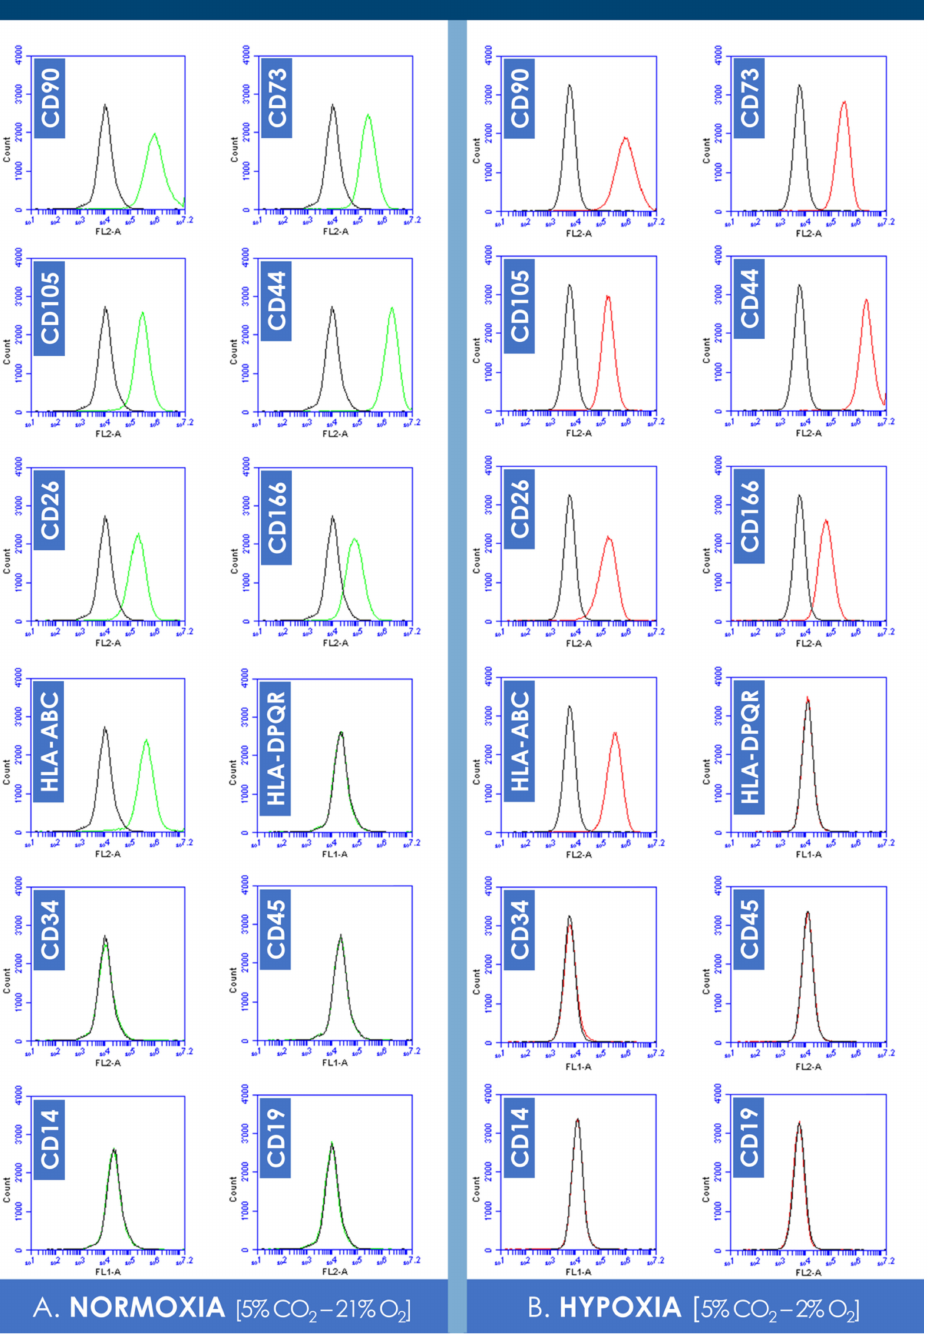
Figure 4. Comparative hFPT surface maker panel expression in normoxic and hypoxic culture conditions. ( A ) Representative flow cytometry data of cell surface marker expression of hFPTs cultured in a normoxic gaseous mix (i.e., green plots) as compared to isotype controls (i.e., black plots). ( B ) Representative flow cytometry data of cell surface marker expression of hFPTs cultured in a hypoxic gaseous mix (i.e., red plots) as compared to isotype controls (i.e., black plots). hFPT, human fetal progenitor